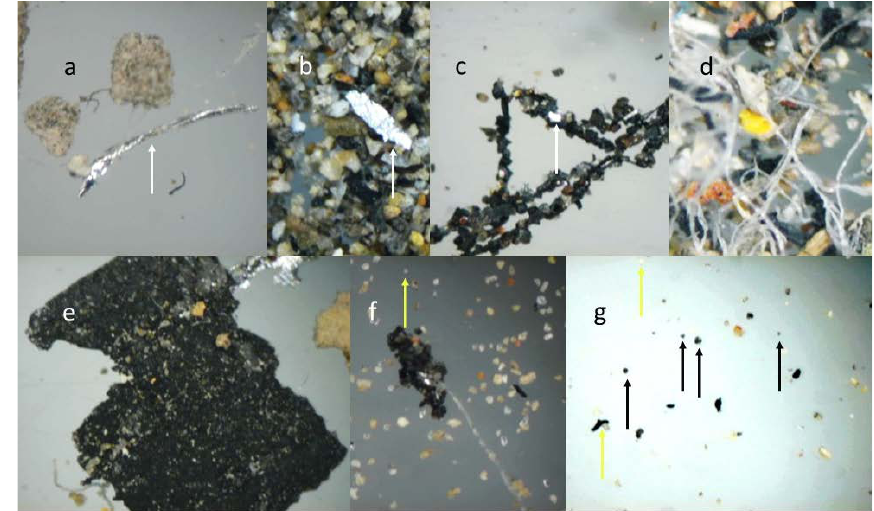
Figure 4. ( a–c ) Representative metallic and ( c–g ) inorganic particles observed by reflected light microscopy; ( d ) Synthetic fibers were also observed. Arrows on f and g indicate small particles.